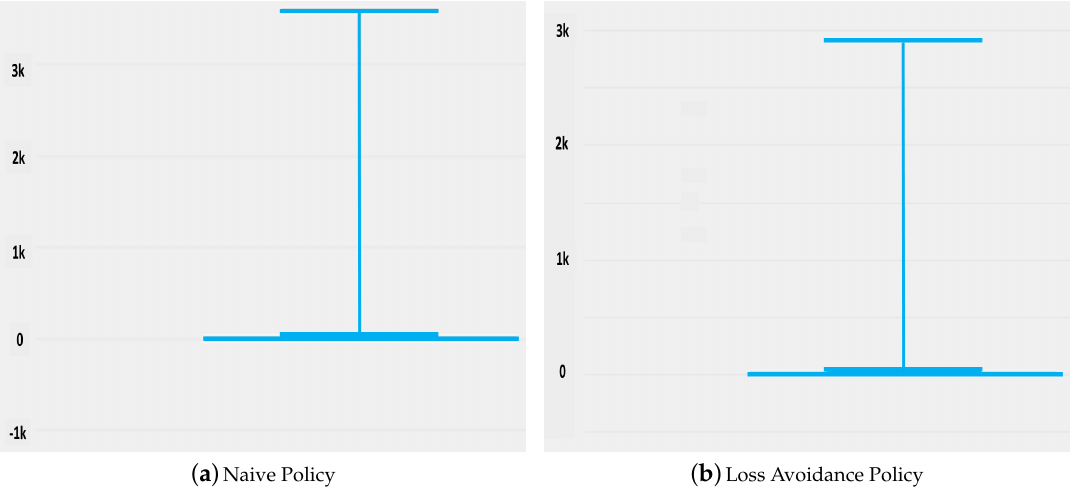
Figure 9. Obtained results for curtailing excess generation of solar panels.